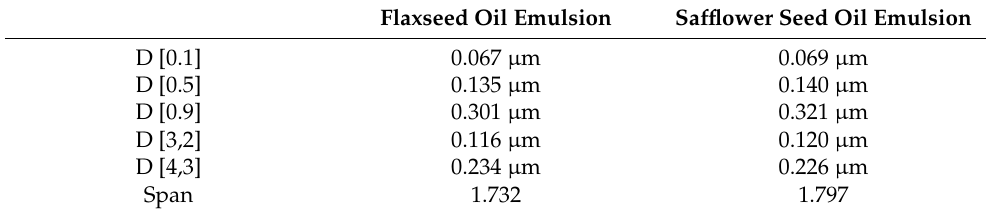
Figure 2. Particle size distributions of flaxseed oil emulsion ( a ) and safflower seed oil emulsion ( b ). Table 4. Particle size results of flaxseed oil and safflower seed oil emulsions.